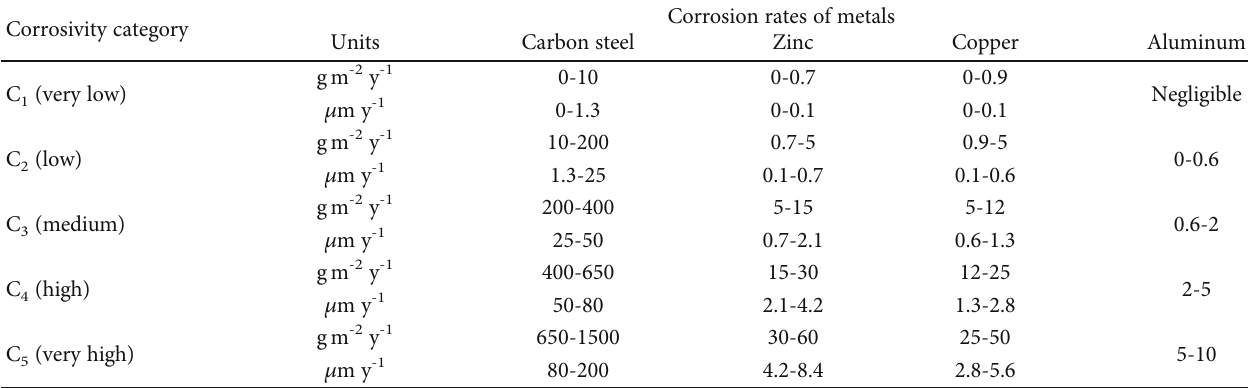
Table 1: Corrosivity category of metals acc. to NBR 14643 [11,